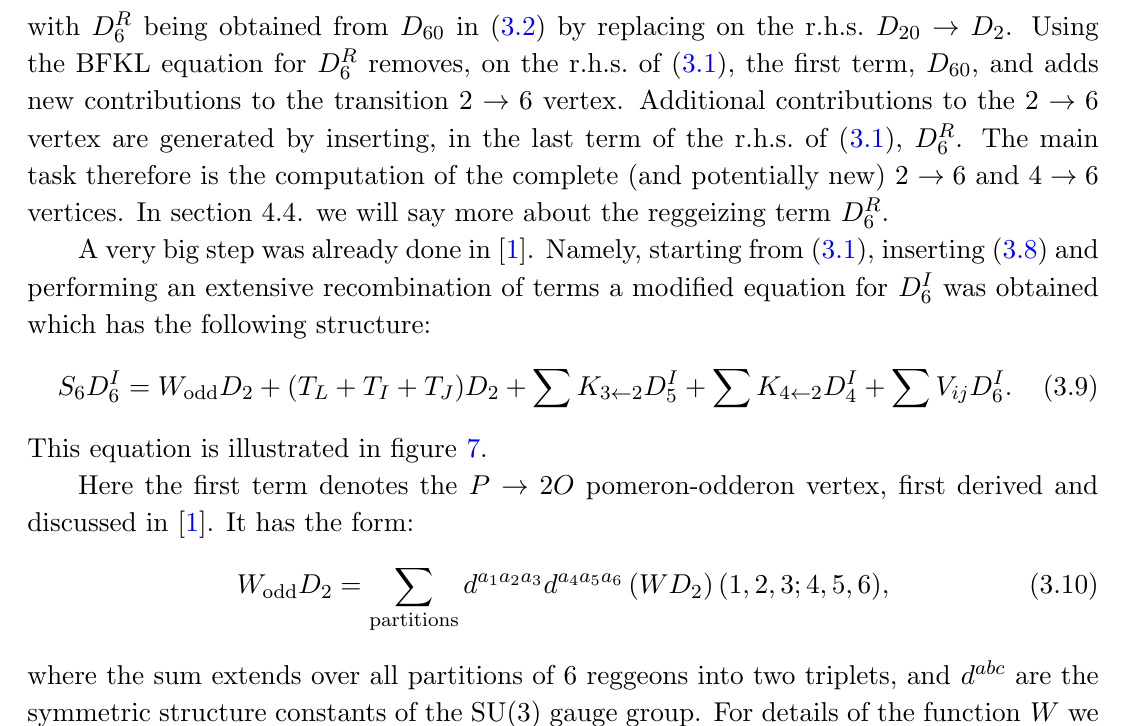
Figure 7 . The integral equation (3.9) for the amplitude D I denoted by ‘L’ and ‘I+J’ the pairs of straight lines attached to the vertices denote reggeons which carry sums of (cid:12)nal momenta. For further explanations see